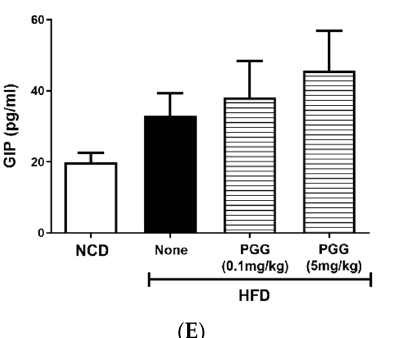
Figure 7. Effect of 12 weeks of β -PGG supplementation on endocrine hormones in DIO mice. Serum levels for ( A ) adiponectin, ( B ) leptin, ( C ) ghrelin, ( D ) glucagon-like peptide-1 (GLP-1), and ( E ) gastric inhibitory peptide (GIP) were measured. Data are shown as mean ± SEM ( n = 4). * p < 0.05, ** p < 0.01 and *** p < 0.001 compared with control diet (NCD) group or vehicle control group. ∆ p < 0.05 and ∆∆ p < 0.01 compared with HFD (none) group.